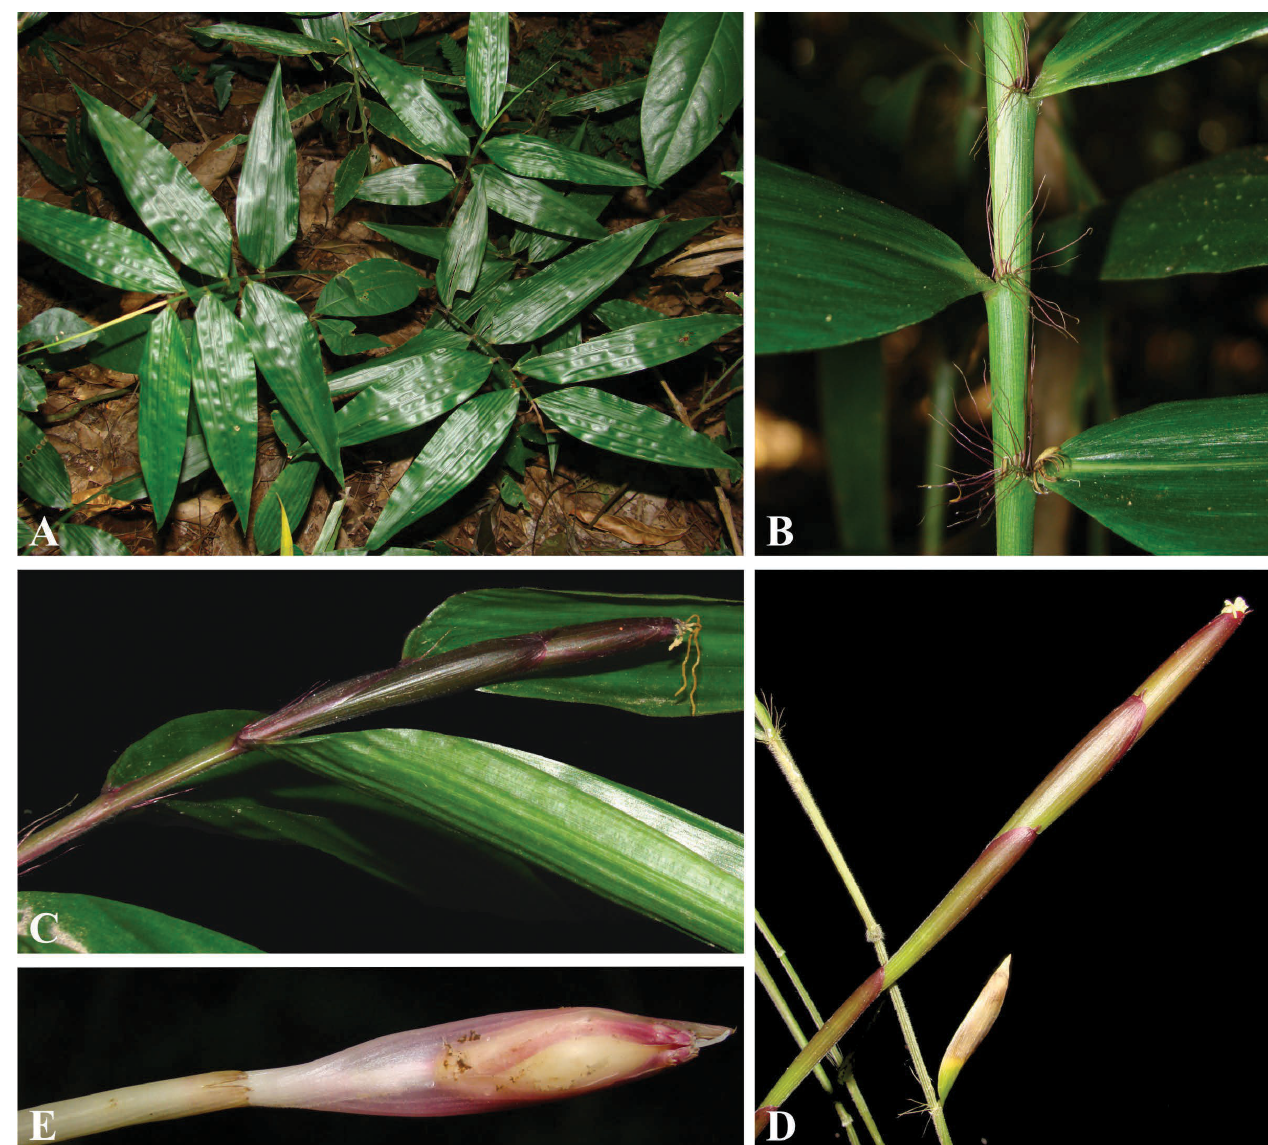
Figure 2 – Eremitis clarkiae (photographs by Fabrício M. Ferreira). A . Habit. B . Detail of the leafy culm showing the fimbriae at the apex of the leaf sheaths. C . Leafy culm inflorescence enclosed by spathaceous bracts. D . Decumbent culm inflorescence enclosed by spathaceous bracts. E . Subterranean culm inflorescence enclosed by spathaceous